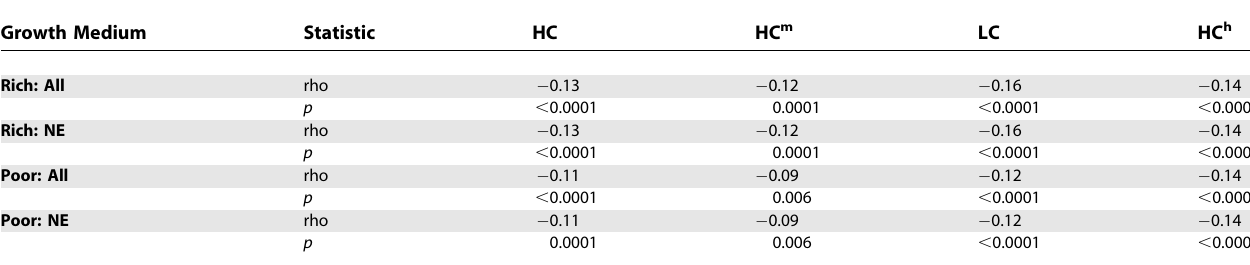
Spearman rank correlations (rho) between noise in protein abundance (controlled for absolute level of protein abundance) and connectivity of a protein. As all correlations are negative and significant, hub proteins thus have lower levels of noise. The test is reported for four protein networks and two growth conditions, and either all proteins (All) or just nonessential proteins (NE) are examined. DOI: 10.1371/journal.pbio.0040317.t003 PLoS Biology |